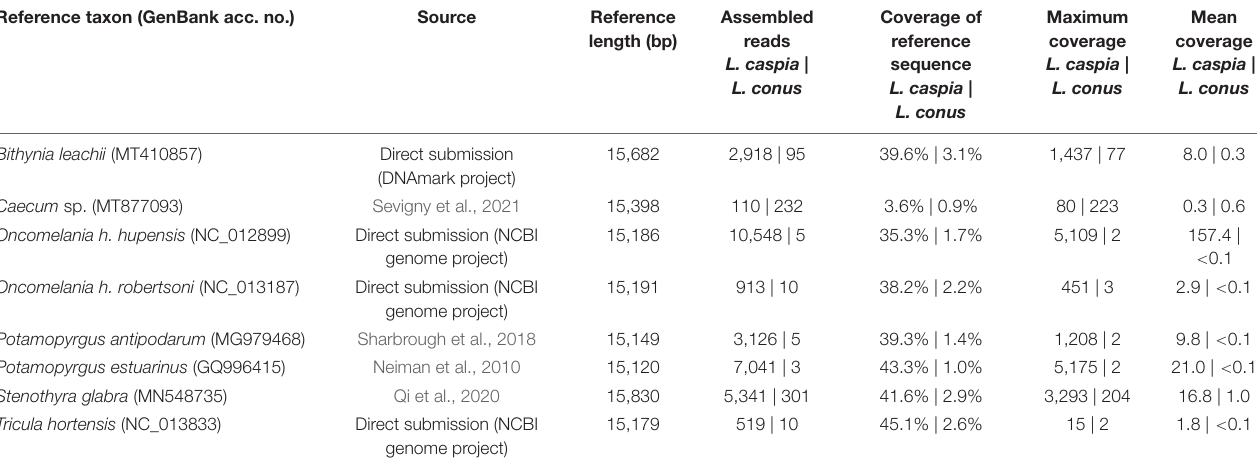
TABLE 1 | Mitogenome mapping for L. caspia and L. conus . Reference taxon (GenBank acc.